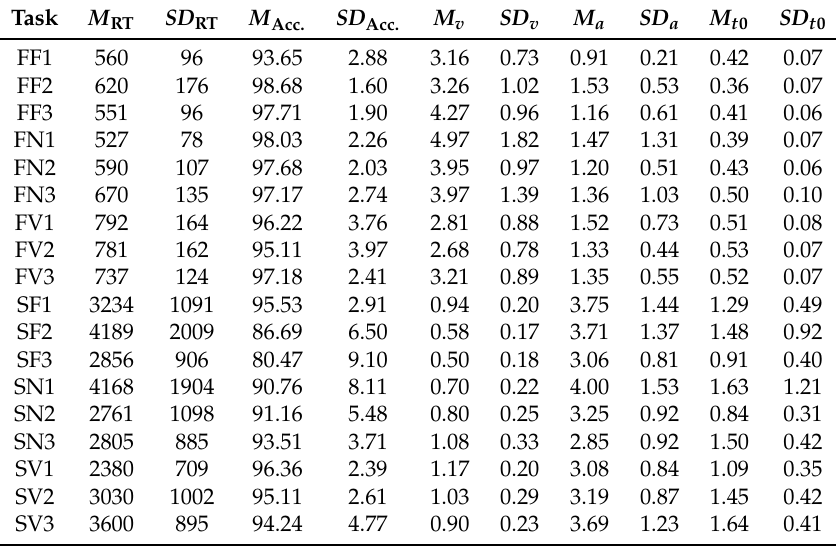
Table 2. Means ( M ) and Standard Deviations ( SD ) of Mean RTs in ms, Accuracy Rates (in %), and the Diffusion Model Parameters for all 18 Tasks.